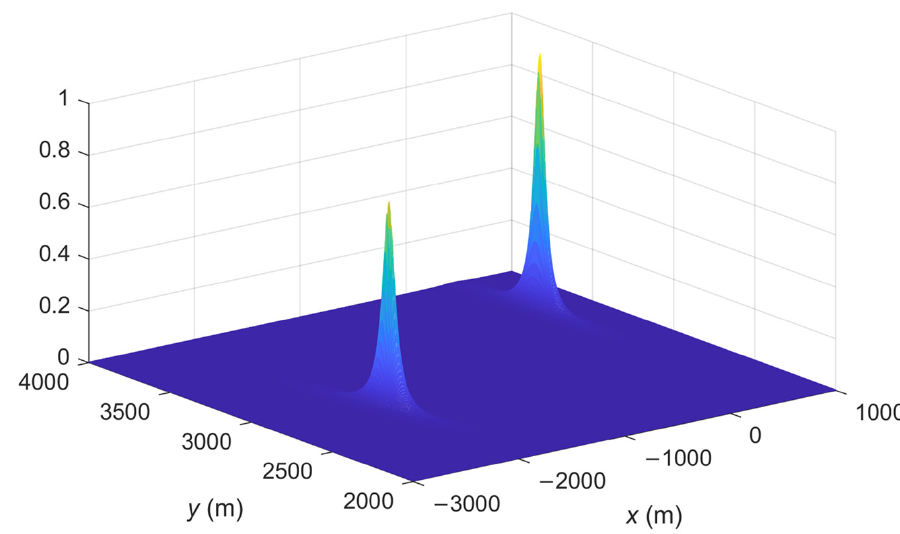
Figure 4. Spatial spectrum of IFLA (stereogram).